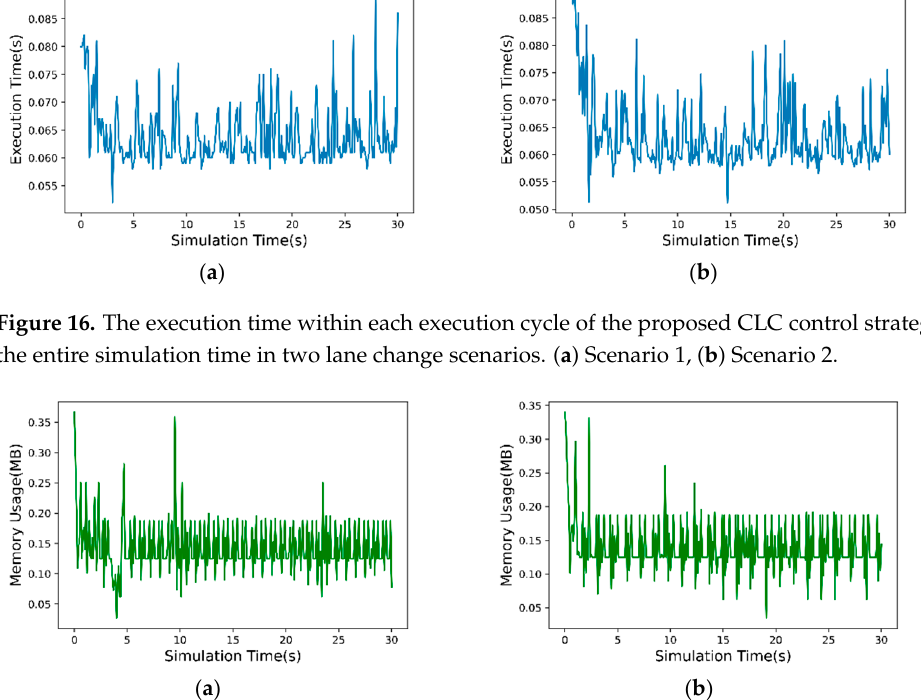
Figure 17. The memory usage within each execution cycle of the proposed CLC control strategy for the entire simulation time in two lane change scenarios. ( a ) Scenario 1, ( b ) Scenario 2.